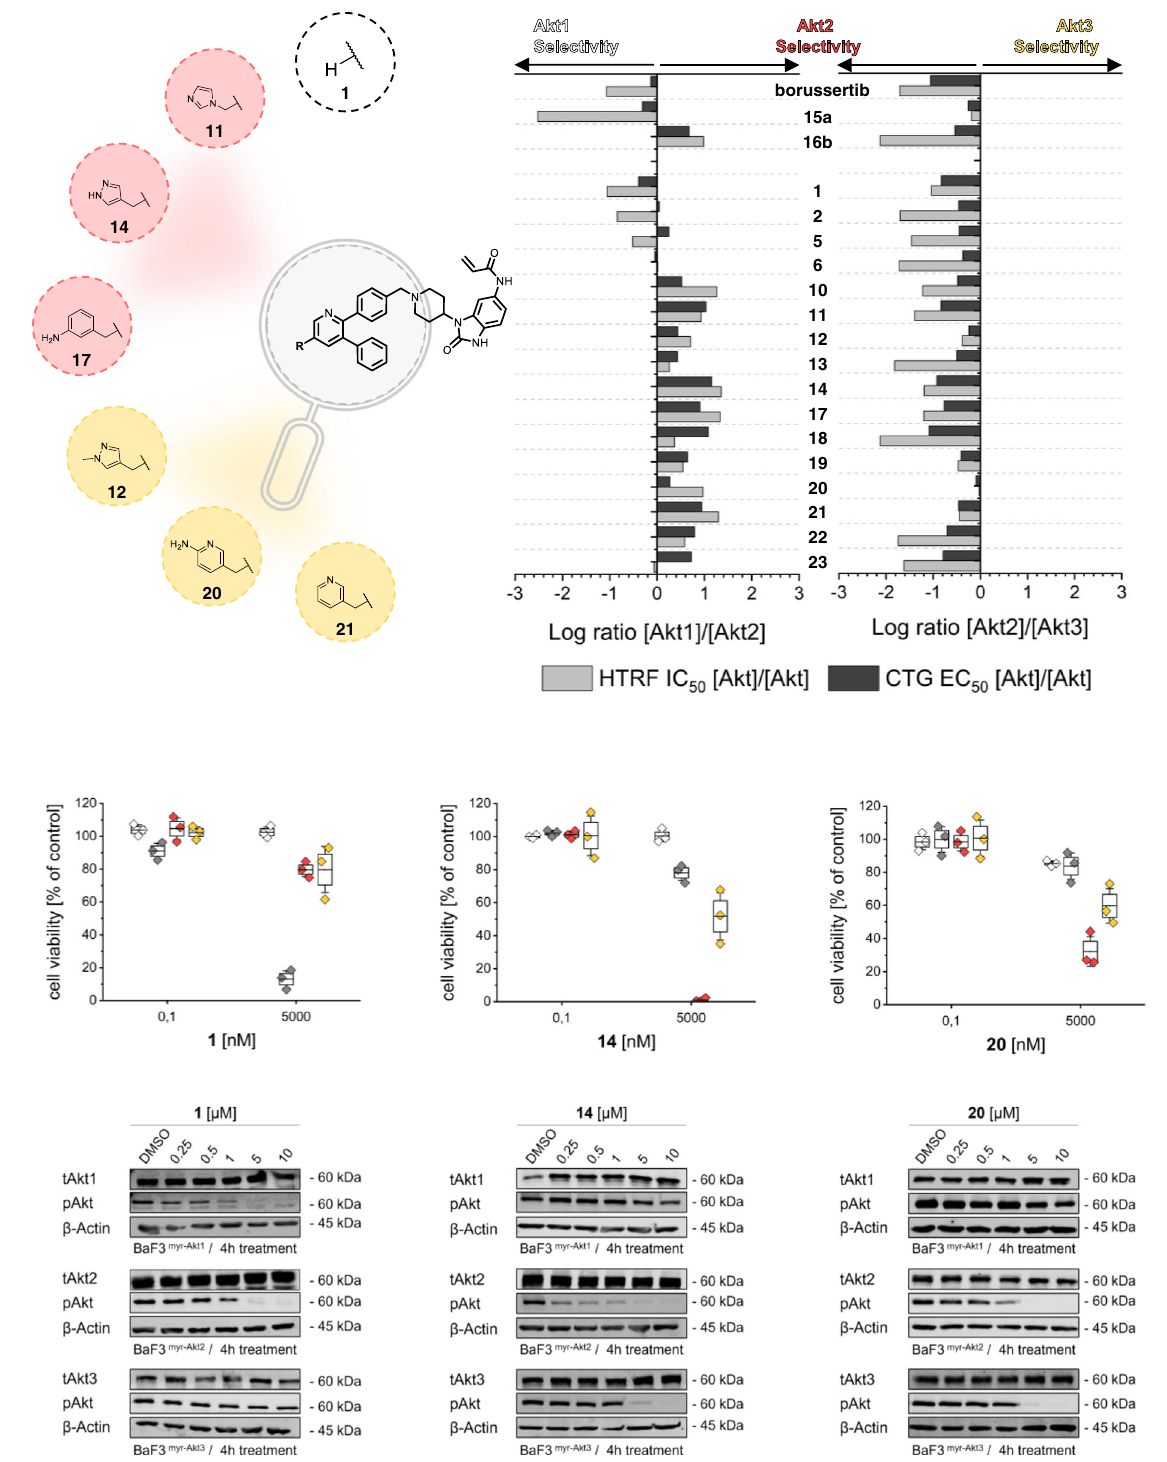
Fig. 4 Investigation of the Ba/F3 myr-Akt isoform system with a focused set of CAAIs. a Identi fi ed biochemical selectivity pro fi les (dark gray) compared to the ratios obtained from Cell Viability Assay with Ba/F3 myr-Akt isoform-dependent cells (light gray). Ratios of selectivity in log units are consistent and underline the successful translation of results from biochemical assays to the cellular system. Structures and residues that highlight the observed translation and qualify as potential probe molecules for further investigations. b More detailed analysis of inhibitor 1 , 14 , and 20 with the three isoform- dependent cell lines. Graph showing the remaining viable cells with respect to the used concentration of CAAI. Experimental points were measured in duplicates for each plate and were replicated in n = 3 biologically independent experiments. The box plot middle line represents the mean value, the box represents the fi rst and third quartile and the error bars indicate s.e. Immunoblots to elucidate dose-dependent downregulation of Akt isoform activity after 4-h treatment ( n = 1 biologically independent experiments. Source Data are provided with this